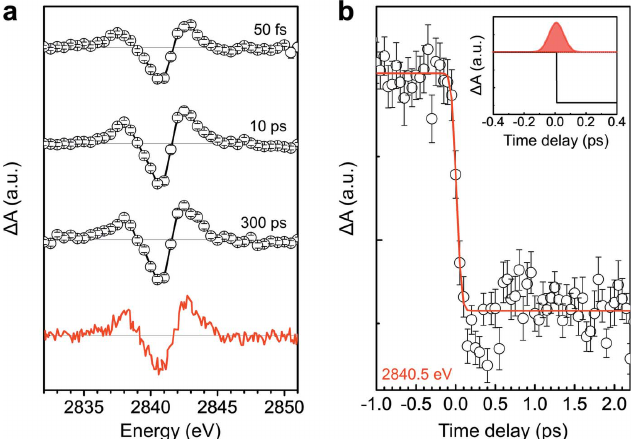
Figure 6 ( a ) Transient Ru L 3 -edge spectra of tris(bipyridine) ruthenium(II) chloride ([Ru(bpy) 3 ] 2+ ) at time delays of 50 fs, 10 ps, and 300 ps (open circles and lines). The previously reported difference spectrum at 300 ps (red solid line) [reprinted with permission from Saes et al. (2003). Copyright (2003) by the American Physical Society]. ( b ) A kinetic trace of transient X-ray absorption spectroscopy (XAS) at the negative transient peak (2840.5 eV). The inset shows the Gaussian instrument response function and the step function resulting in the fitted